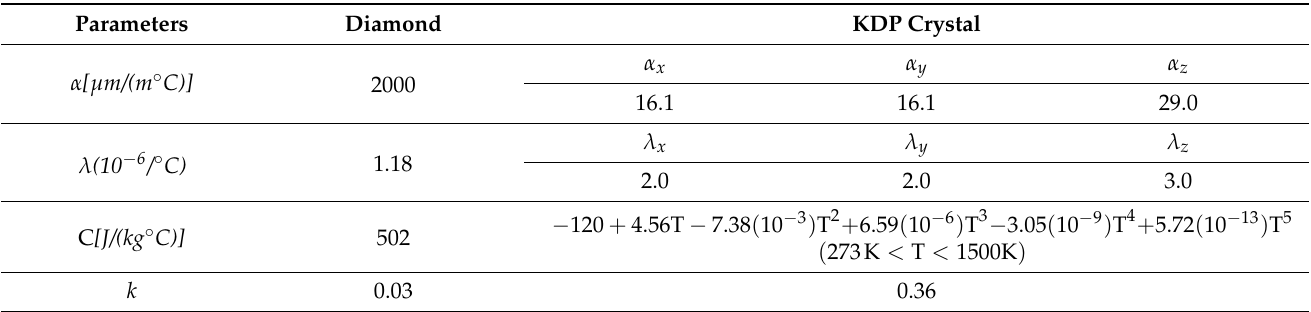
Table 3. Thermal parameters of diamond tools and type II KDP crystals.